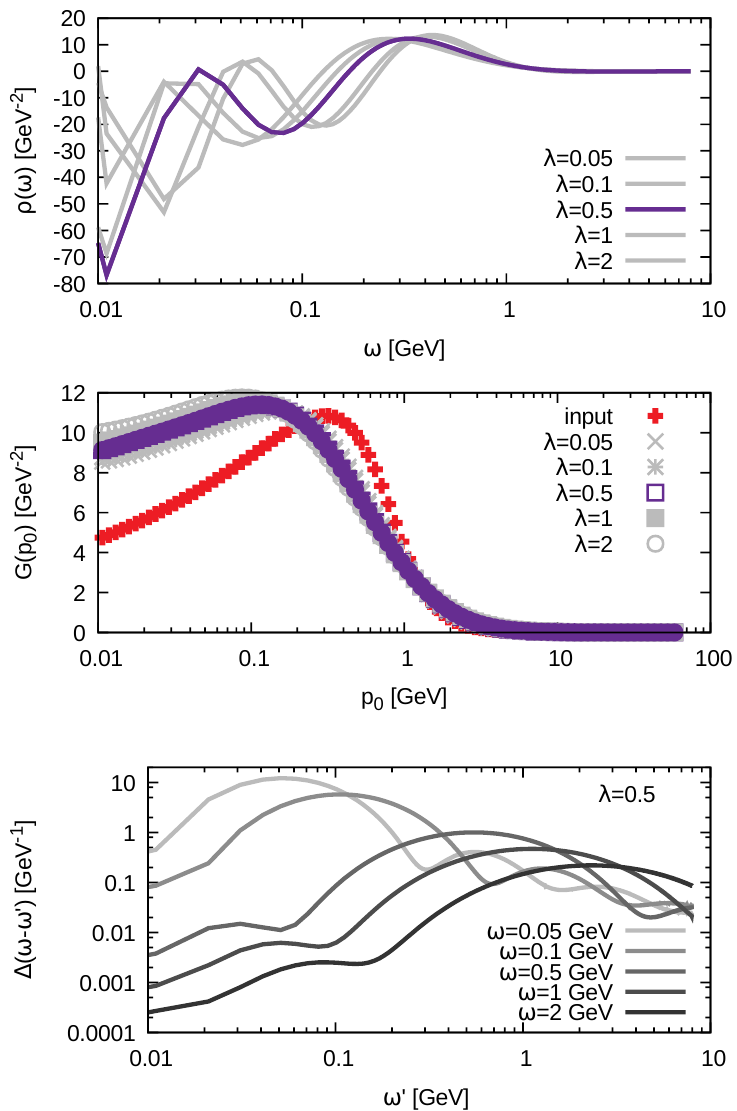
Figure 10: (top) Series of Backus-Gilbert reconstructed spectral functions us- ing the Tickhonov regularization prescription for different regulator parameter λ = [ 0.05..2 ] . Note that the reconstruction identifies the presence of both the nega- tive trough close to the origin and the one above the main peak at around ω > 1GeV. Ringing at small frequencies is not cured by simply increasing the value of λ . The best choice λ = 0.5 is given in dark violet, while the other values are denoted by light gray curves. (center) Euclidean data of the reconstructed spectra compared to the original input (red). The result corresponding to λ = 0.5 (dark violet) works > 1GeV but misses the position of the main peak structure relatively well above p 0 and exhibits too weak of a backbending. (bottom) Resolution function ∆ ( ω − ω (cid:48) ) for the best choice λ = 0.5 plotted for